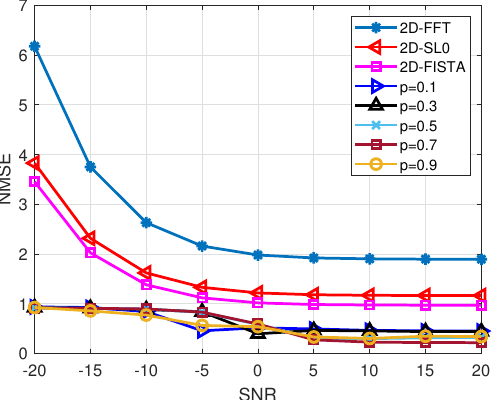
Figure 4. The relationship between the SNR and NMSE.